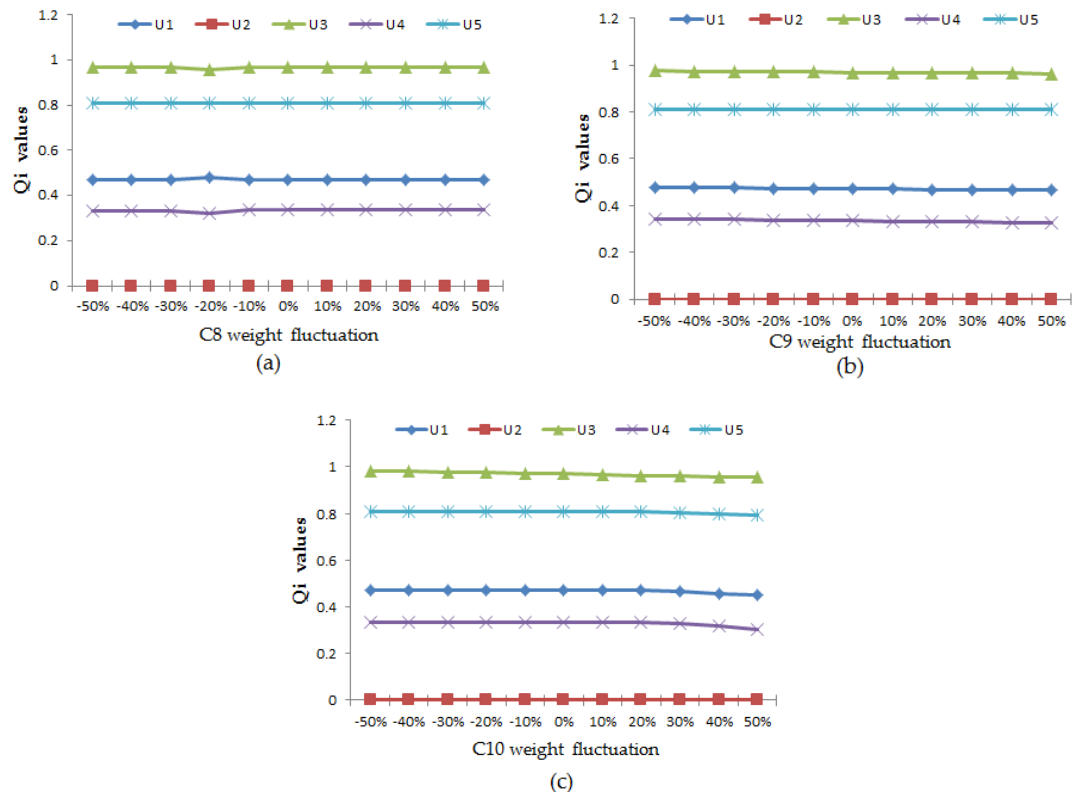
Figure 8. Weight sensitivity analysis for social benefits criteria. ( a ) Weight sensitivity analysis for sub-criterion C8. ( b ) Weight sensitivity analysis for sub-criterion C9. ( c ) Weight sensitivity analysis for sub-criterion C10.